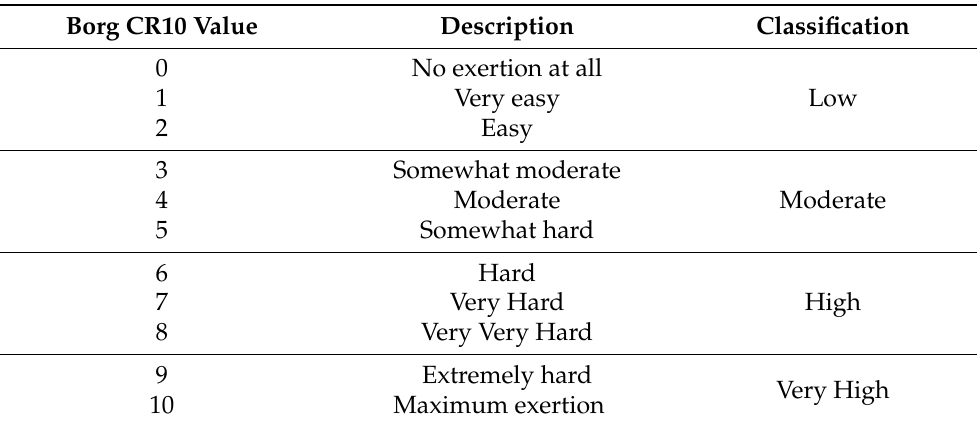
Table 3. Borg scale description and